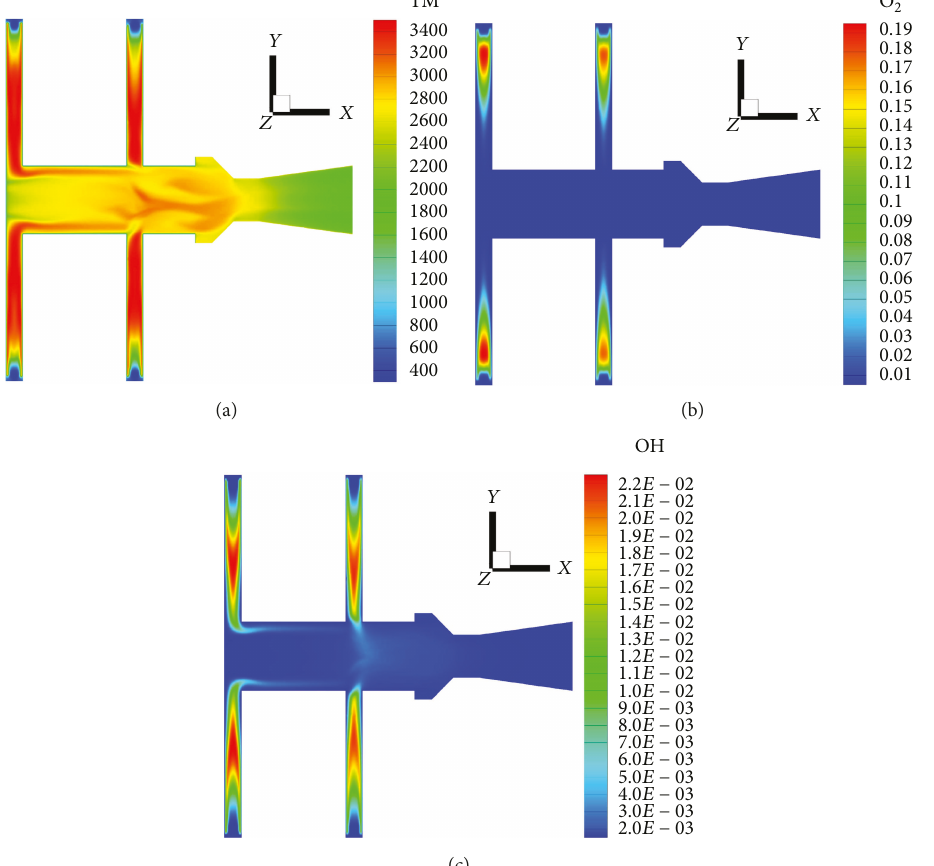
Figure 9: Instantaneous planar distributions on XY section: (a) temperature (K), (b) mass fraction of O